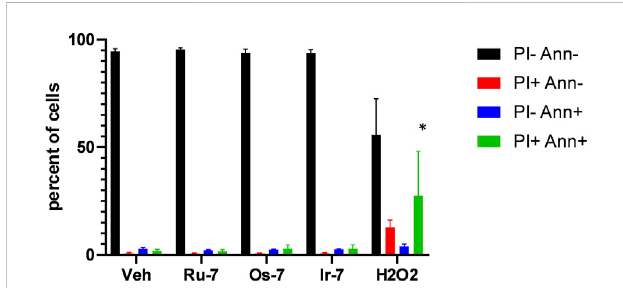
FIGURE 6 Quinoline complexes do not induce cell death. 2 × 10 6 A2780 cells were plated in 12 well plates and were treated with the complexes ( Ru-7 at 0.846 μ M, Os-7 at 0.578 µM and Ir-7 at 0.891 µM) and 300 µM hydrogen peroxide for 2 h. Cells were then stained with Annexin V and propidium iodide (PI) and cells were subjected to fl ow cytometry as describedinMaterialsandMethods.Thepercentofcellsinthequadrants are plotted. Data is represented as average ± SD, from three biological replicates, individual assays were performed in duplicates. Normal distribution was achieved by Box-Cox normalization of the data. Statistical signi fi cance was determined using a two-way ANOVA test, all measurement points were compared with each other. * indicate statistically signi fi cant differences betweenvehicle-treated (control) and treated cells (complexes or 300 µM H 2 O 2 ) corresponding to the same quadrant (e.g., vehicle-treated double negative cells vs. H 2 O 2 -treated double negative cells) at p <